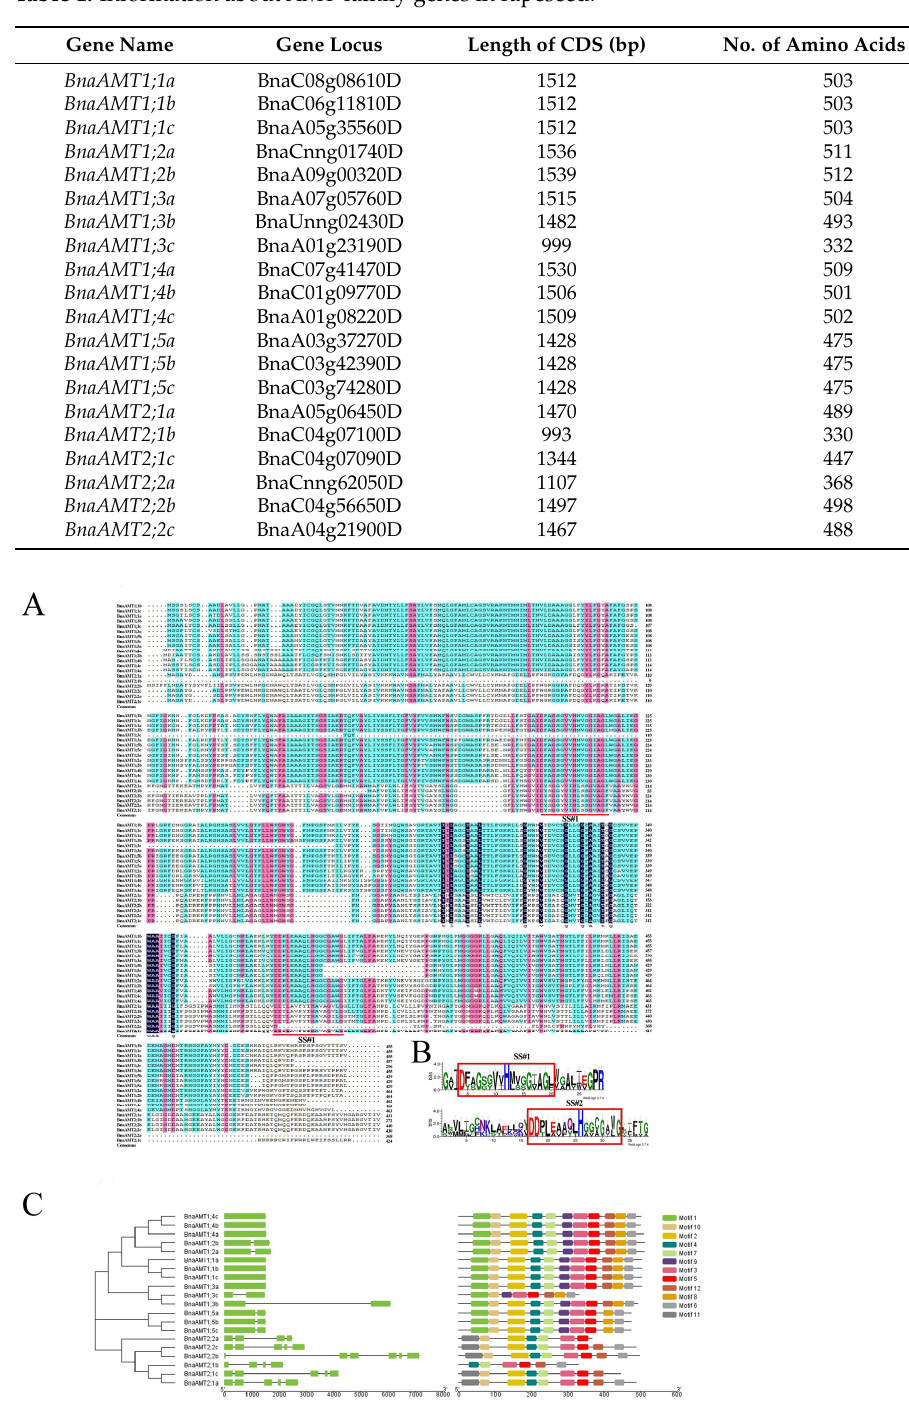
Figure 1. Multiple alignment of rapeseed AMT family proteins and gene structure/conserved motifs characteristic of rapeseed AMT family members. ( A ) Multiple alignment of amino sequences of BnaAMTs. Red lines underneath alignments indicate two reported signature sequences within the AMT family. ( B ) The logo of these signature sequences. ( C ) The gene structure map of BnaAMTs . Green boxes indicate exons while black lines represent introns. The conserved motifs of rapeseed AMT proteins were analyzed through MEME.